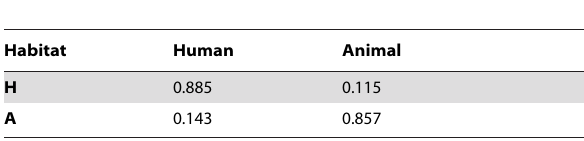
Table 1. The emission probabilities for two inferred habitats.